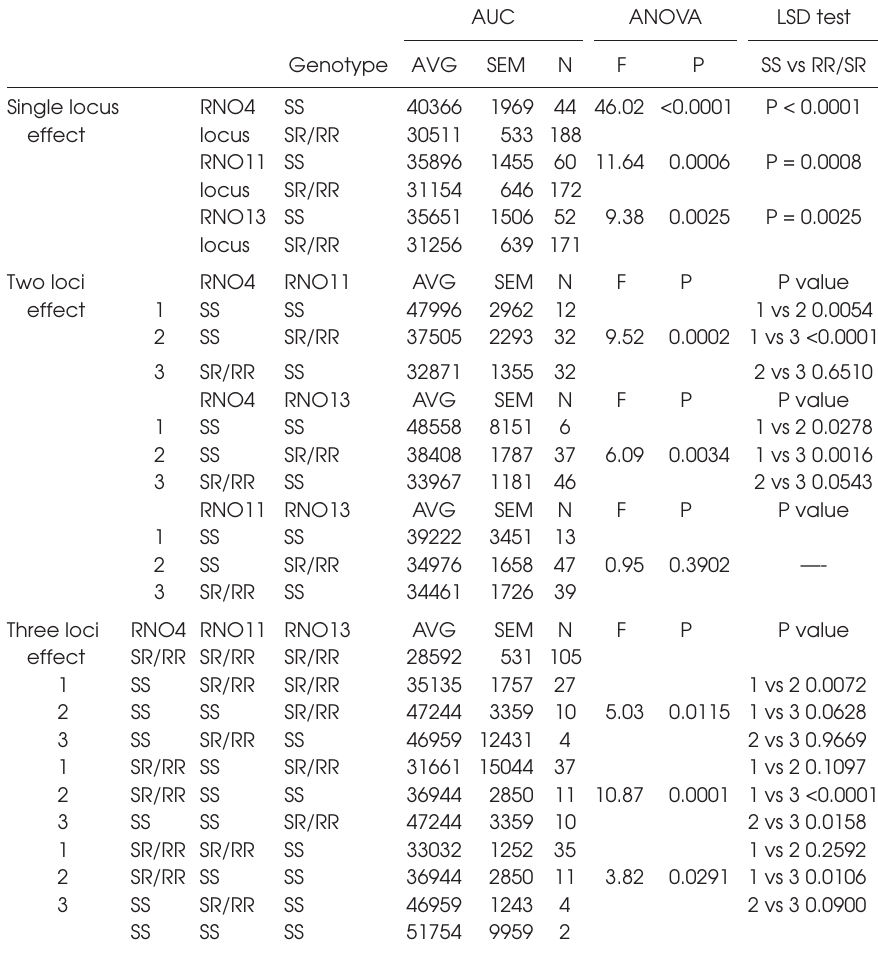
Table 1. Cosegregation analysis for representative microsatellite markers within the genomic loci on RNO4, -11 and